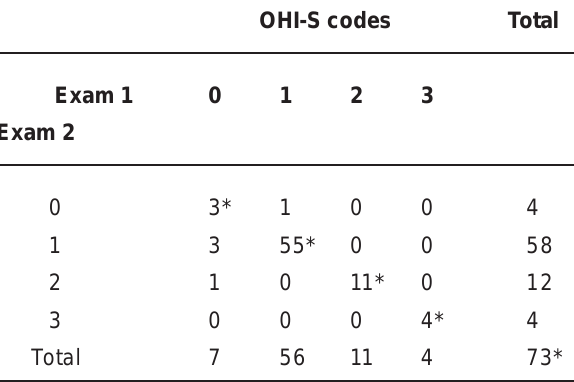
Note: *values in bold in the diagonal correspond to the concordant values in both examinations TABLE 2 - Means of the OHI-S indexes in the initial (OHI-S 1) and final stages (OHI-S 2) and proportion of plaque reduction according to the groups in students aged 12 to 14 years. Piracicaba, 2000